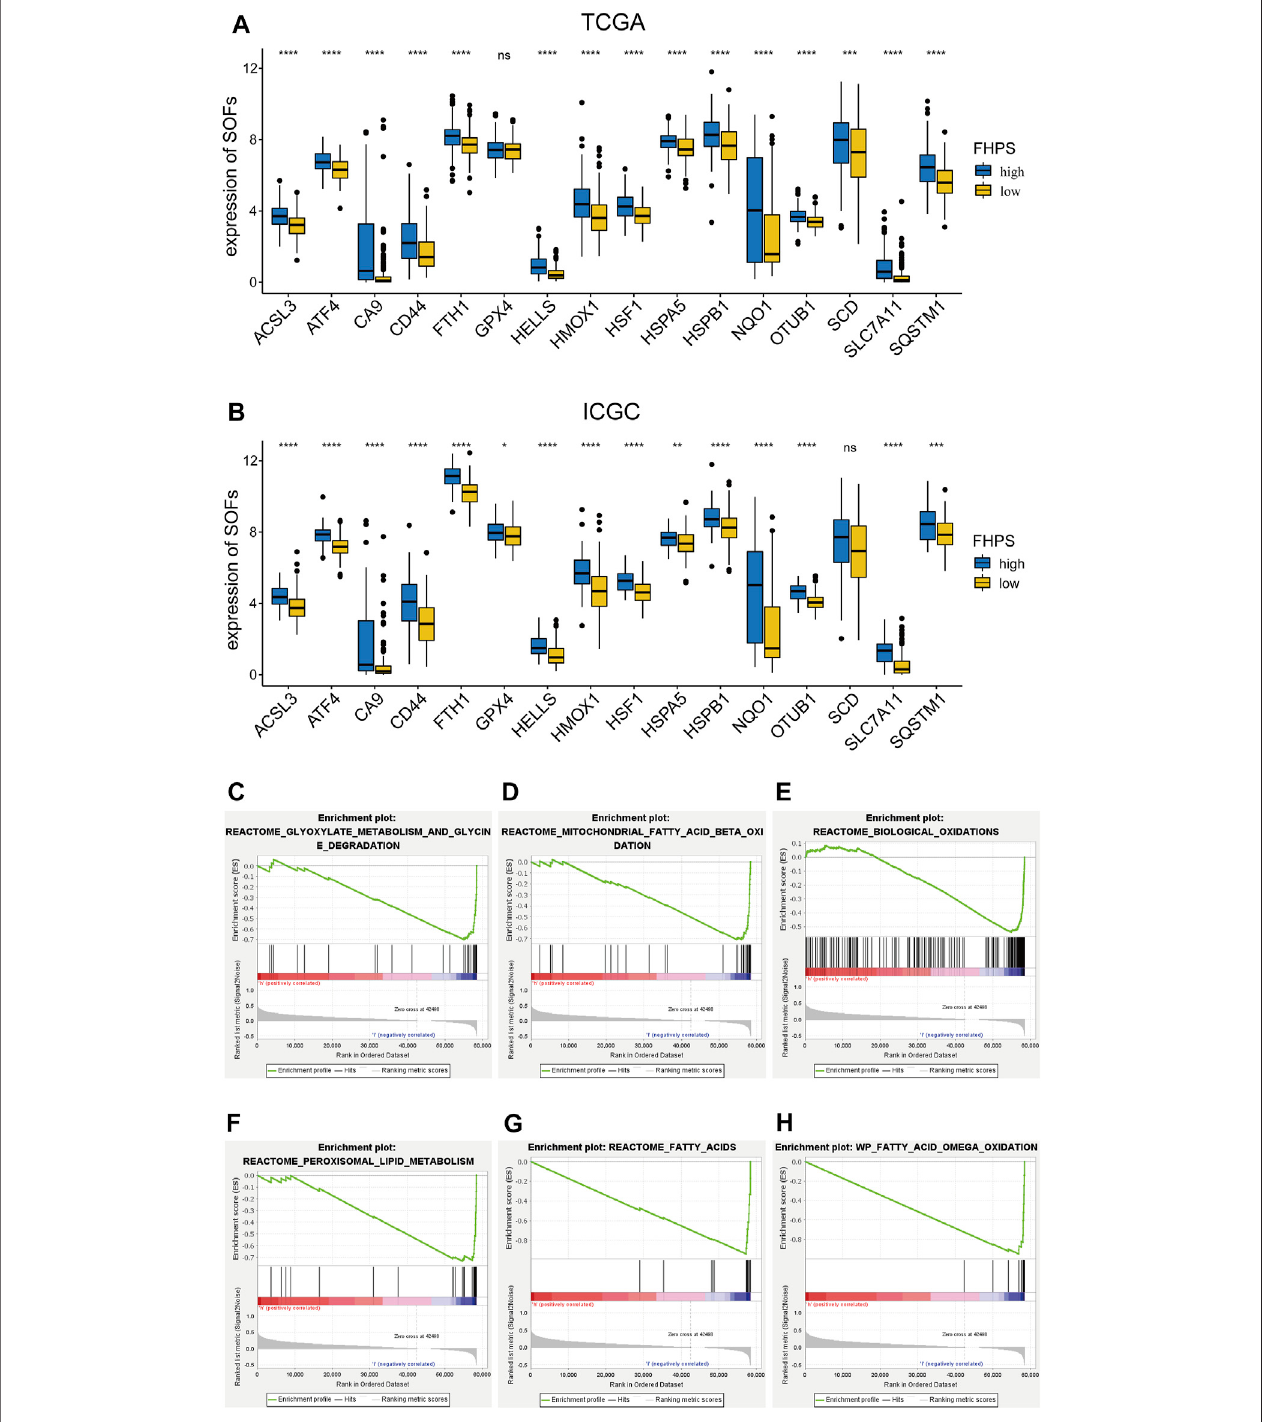
FIGURE 5 | (A, B) Comparison of the expressions of the suppressors of ferroptosis between the high- and low-FHPS groups of the (A) TCGA and (B) ICGC cohorts. (C – H) Gene set enrichment analysis (GSEA) (Ferroptosis-related pathways) of the high-FHPS and low-FHPS subgroups in the TCGA cohorts. * p < 0.05; ** p < 0.01; *** p < 0.001; **** p < 0.0001.